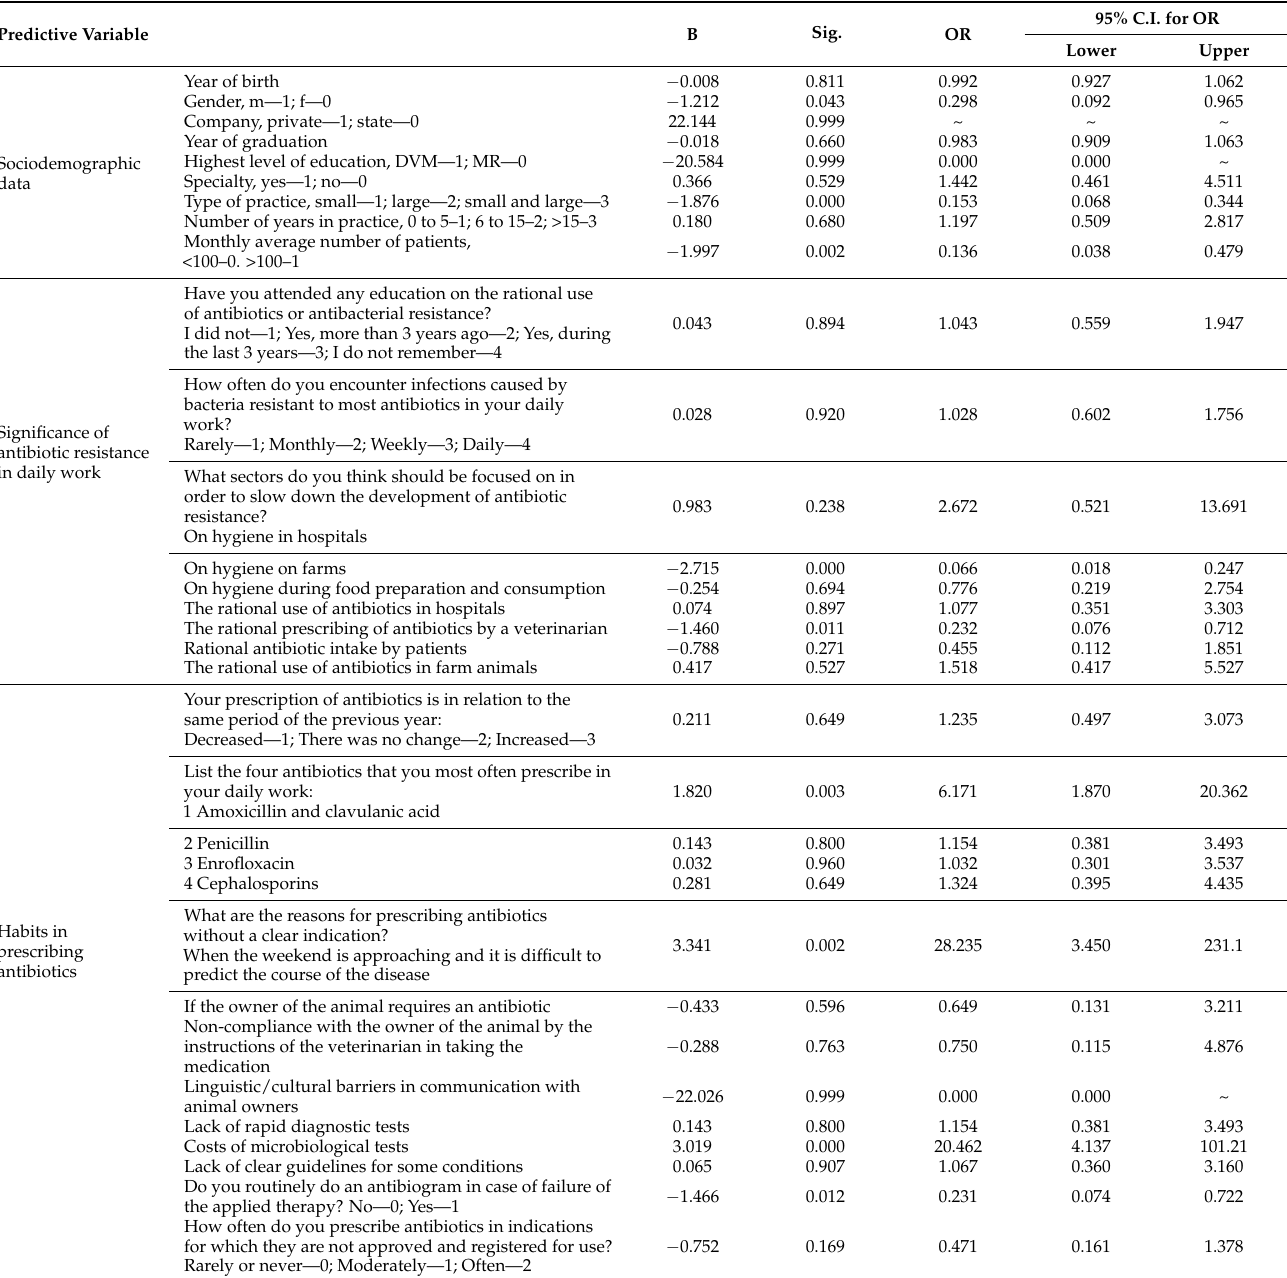
Table 6. Logistic regression for factors predicting poor antibiotic knowledge as the dependent